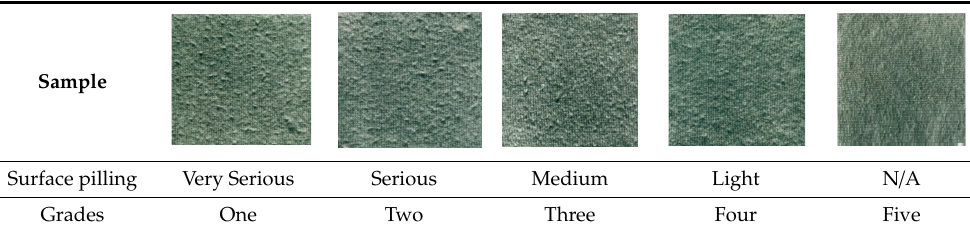
Table 1. Five grades of pilling detection.